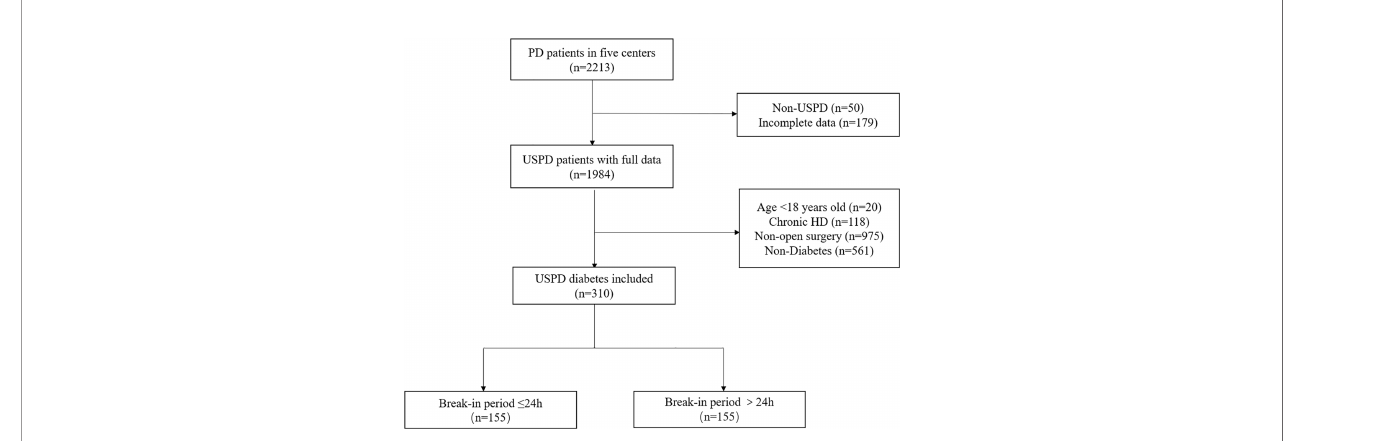
FIGURE 1 | Flowchart. PD, peritoneal dialysis; USPD: urgent start PD; HD,